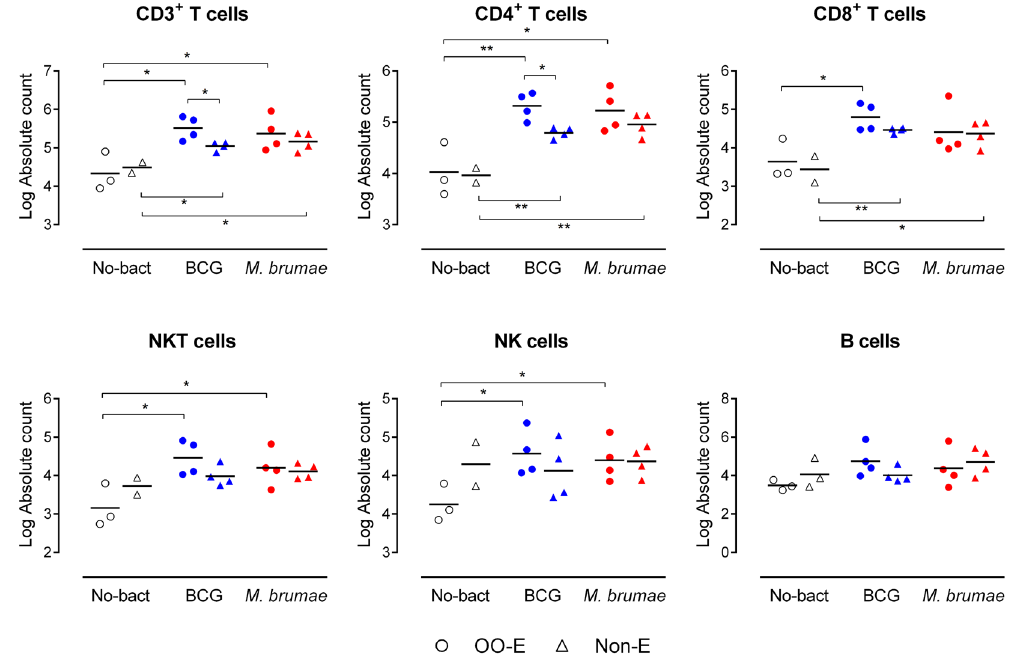
Figure 1. Infiltrated immune cells into mycobacteria-treated and non-treated tumor bearing mice 29 days after tumor induction. Absolute number of T cells (CD3 + , CD4 + and CD8 + subsets), NKT cells, NK cells and B cells that infiltrated the bladder. The different groups of animals are indicated using different colors on the horizontal axis of the graph: non-mycobacteria treated mice (No-bact) are represented by empty black symbols, BCG- treated mice by blue symbols and M. brumae -treated mice by red symbols. Dots represent animals treated with emulsion or emulsionated mycobacteria, triangles represent mice treated with PBS or mycobacteria in PBS. * p < 0.05; ** p <